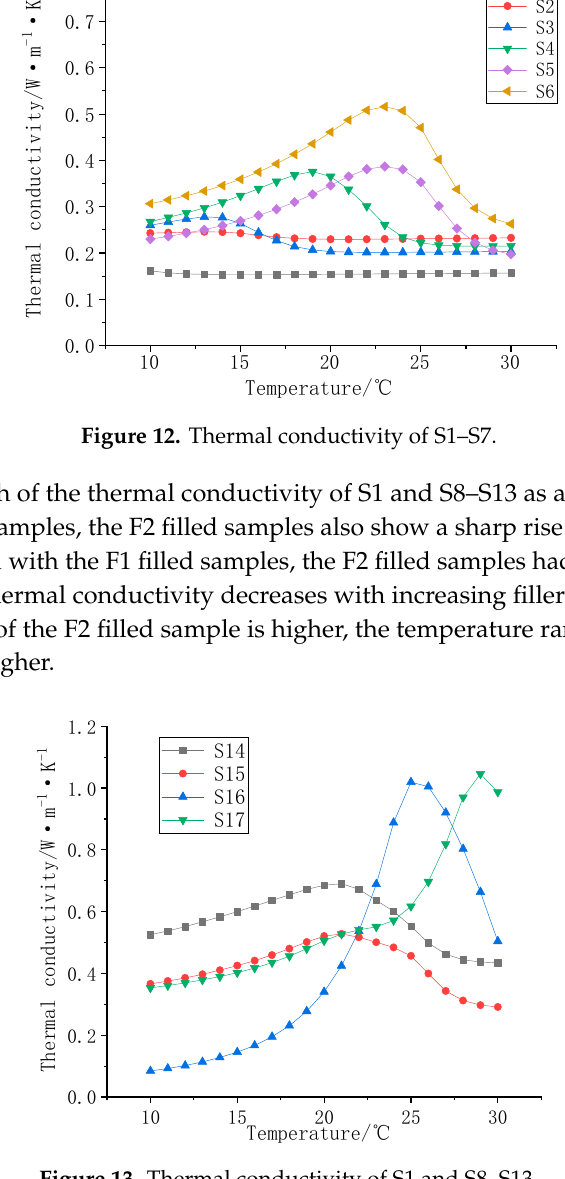
Figure 13. Thermal conductivity of S1 and S8–S13.